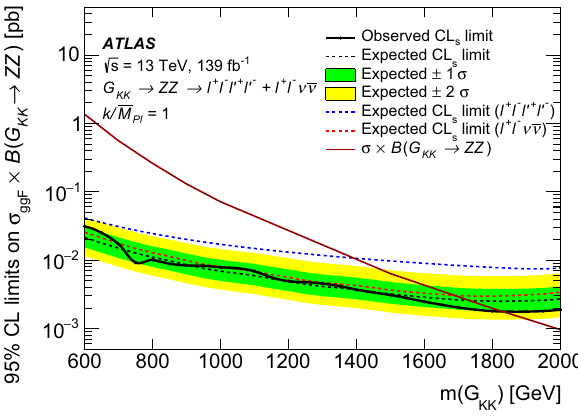
Fig. 8 The upper limits at 95% CL on cross section times branching ratio σ × B ( G KK → Z Z ) for a KK graviton produced with k / M Pl = 1. The black line indicates the observed limit. The green and yellow bands give the ± 1 σ and ± 2 σ uncertainties in the expected limits. The predicted production cross section times branching ratio as a function of the G KK mass m ( G KK ) is shown by the red solid